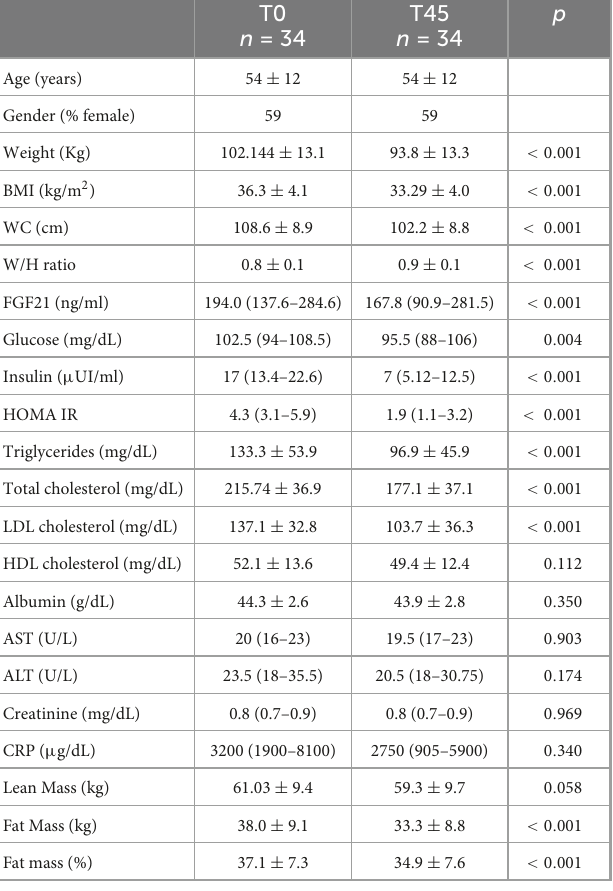
TABLE 1 Participants characteristics at baseline (T0), and after the very low-calorie ketogenic diet (VLCKD) (T45). T0 n =